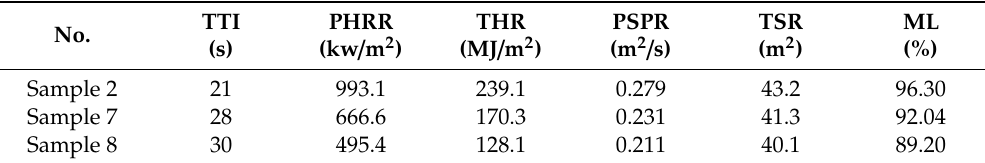
Table 2. Flammability characteristics obtained from cone calorimeter tests.